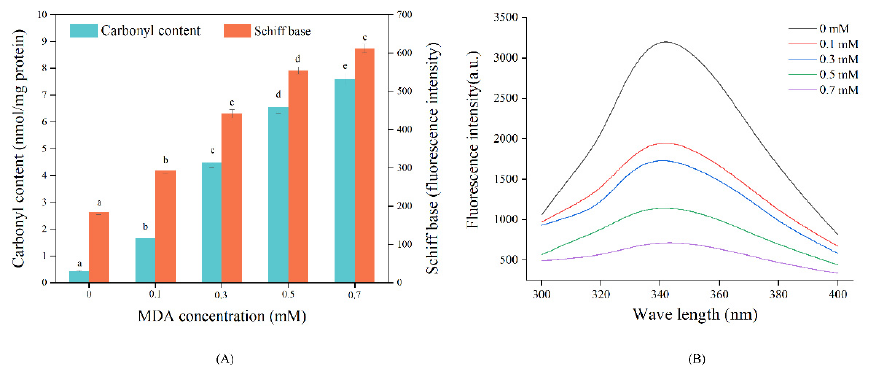
Figure 1. Effect of MDA on MP carbonyl, Schiff base content ( A ), and tryptophan endogenous fluo- rescence ( B ). Different letters (a, b, c, d, e) indicate a significant difference ( p < 0.05, n = 5).